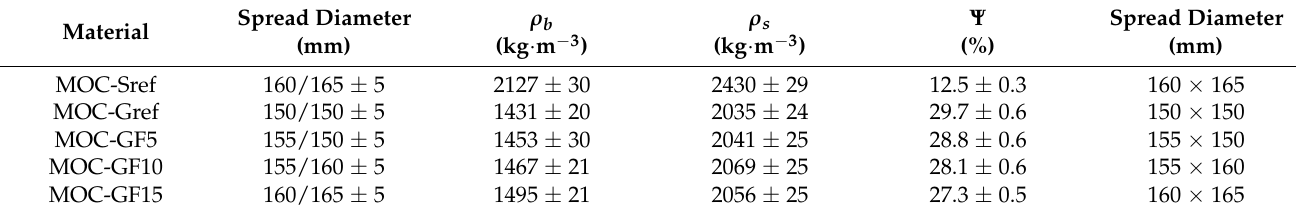
Table 4. Spread diameter and basic macrostructural parameters of developed composites. Spread Diameter Material